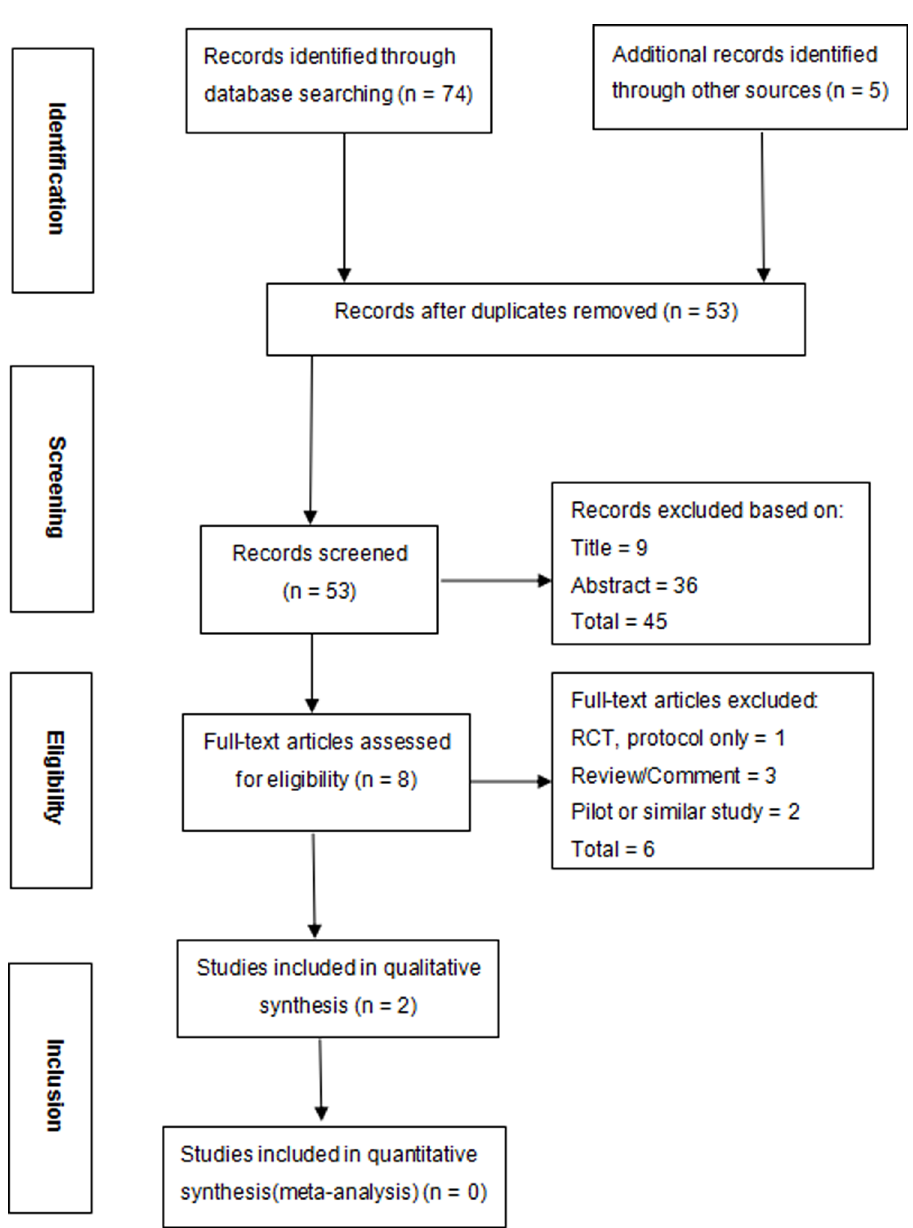
Fig 1. PRISMA 2009 flow diagram. PRISMA, Preferred Reporting Items for Systematic Reviews and Meta-Analyses; RCT, randomized controlled trial.